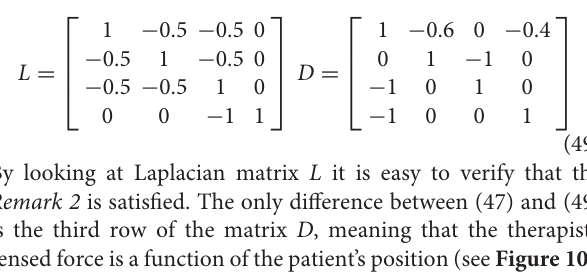
trainee stop moving, and the patient is asked to move.